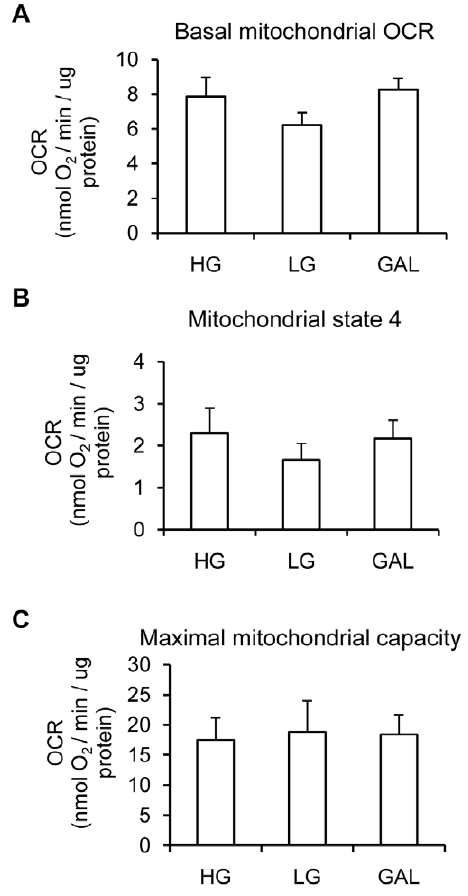
Figure 4. Effect of an acute treatment with galactose medium on myotube aerobic capacity. A. Basal oxygen consumption rate. B. State 4 respiration (leak dependent; non-phosphorylating). After basal oxygen consumption rate measurement, cells were treated with oligomycin (600 ng/ml) to determine state 4 respiration. C. Maximal oxygen consumption capacity. After basal and state 4 respiration, cells were treated with FCCP (1 m M) to determine maximal oxygen consumption. A–C. Myotubes were differentiated for 7 days in LG (5 mM glucose). On the 7 th day of differentiation, myotubes were exposed to HG (25 mM), LG (5 mM glucose) or GAL (10 mM galactose) for 45 min before measuring basal oxygen consumption rate. Results are presented as means 6 SEM, n=4, in which each condition was assessed in 5 replicates.